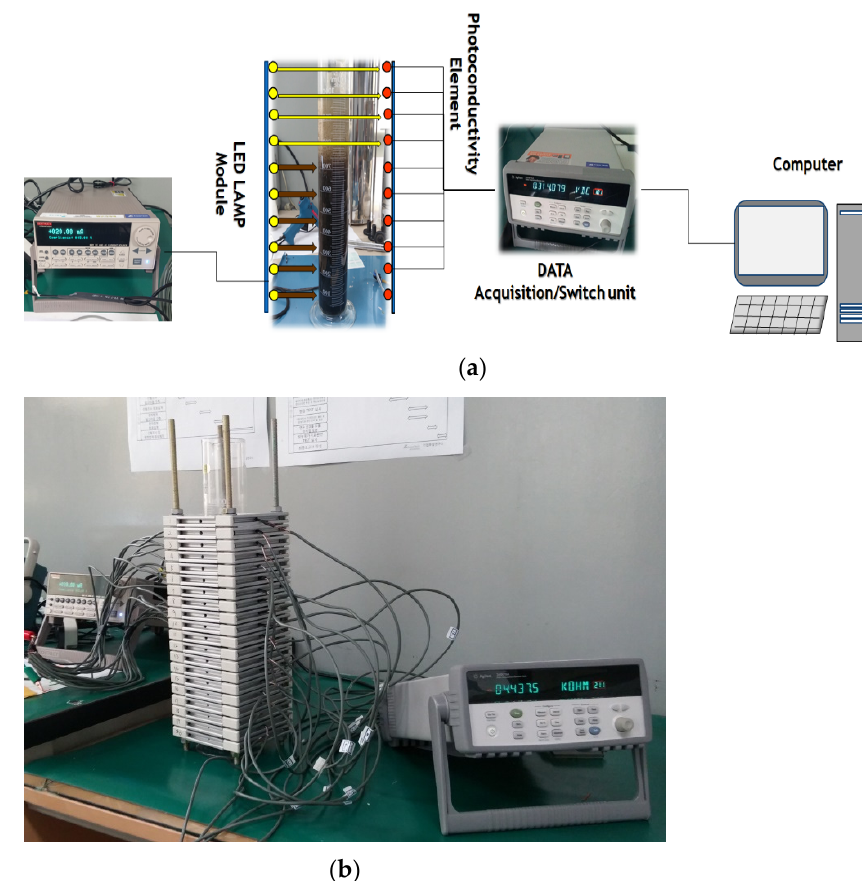
Figure 1. ( a ) Flow chart of the sludge settling test device. ( b ) Photo of the sludge settling test device set. Table 1. Electrical and optical characteristics (Ta = 25 °C ).